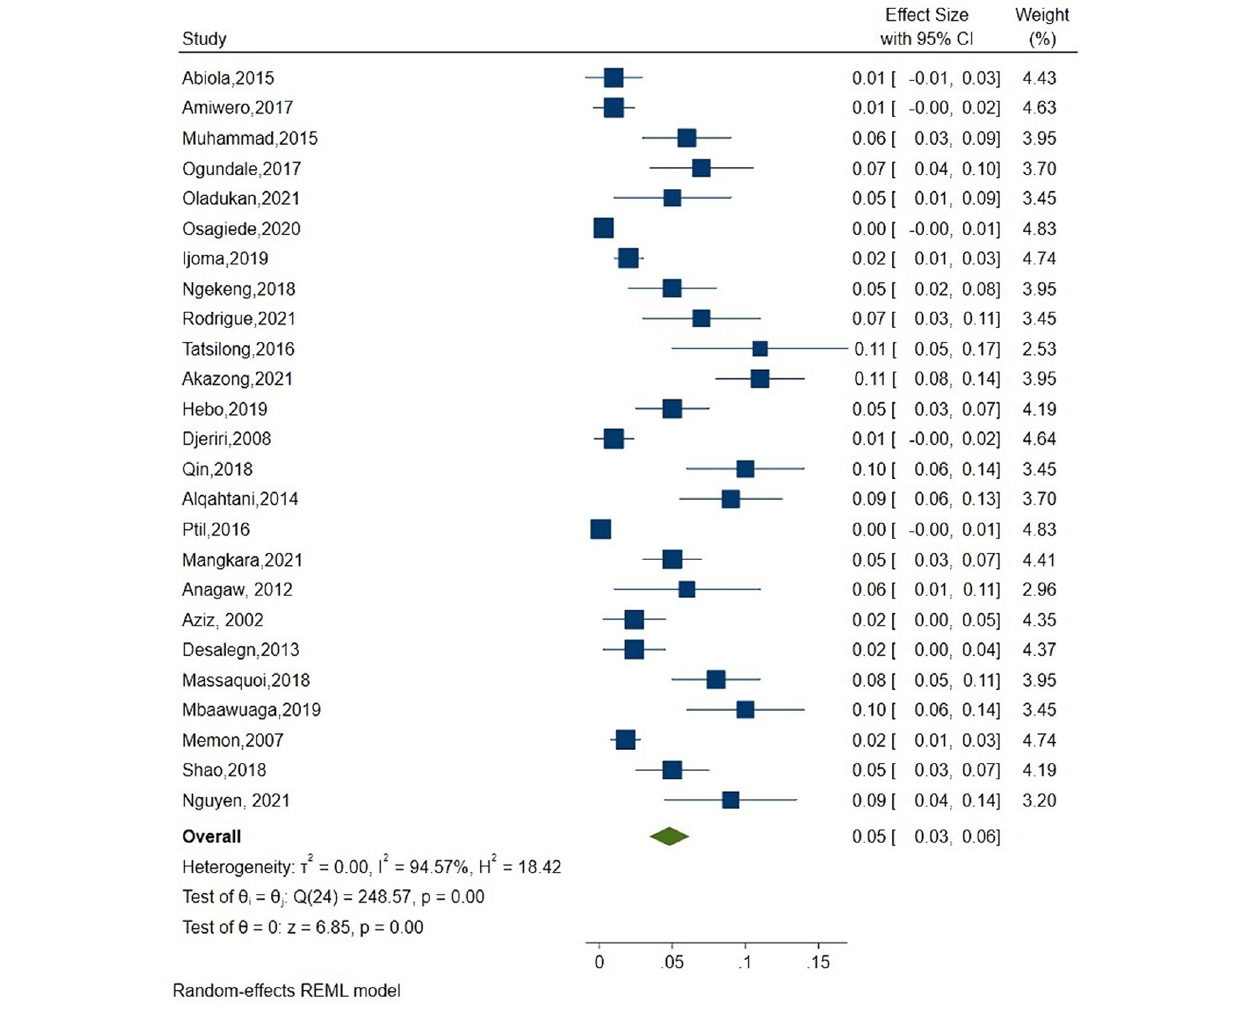
knowledge was reported in the cohort with a seroprevalence of 8.7% in the Asia region (49) Memon et al. (51) and Mangkara et al. (47) found poor knowledge in their participants with 4.7% and 5.0% HBV seroprevalence, respectively. However, Nguyen et al. (48), who found the highest seroprevalence (9.8%), claimed that participants had a good knowledge of HBV infection